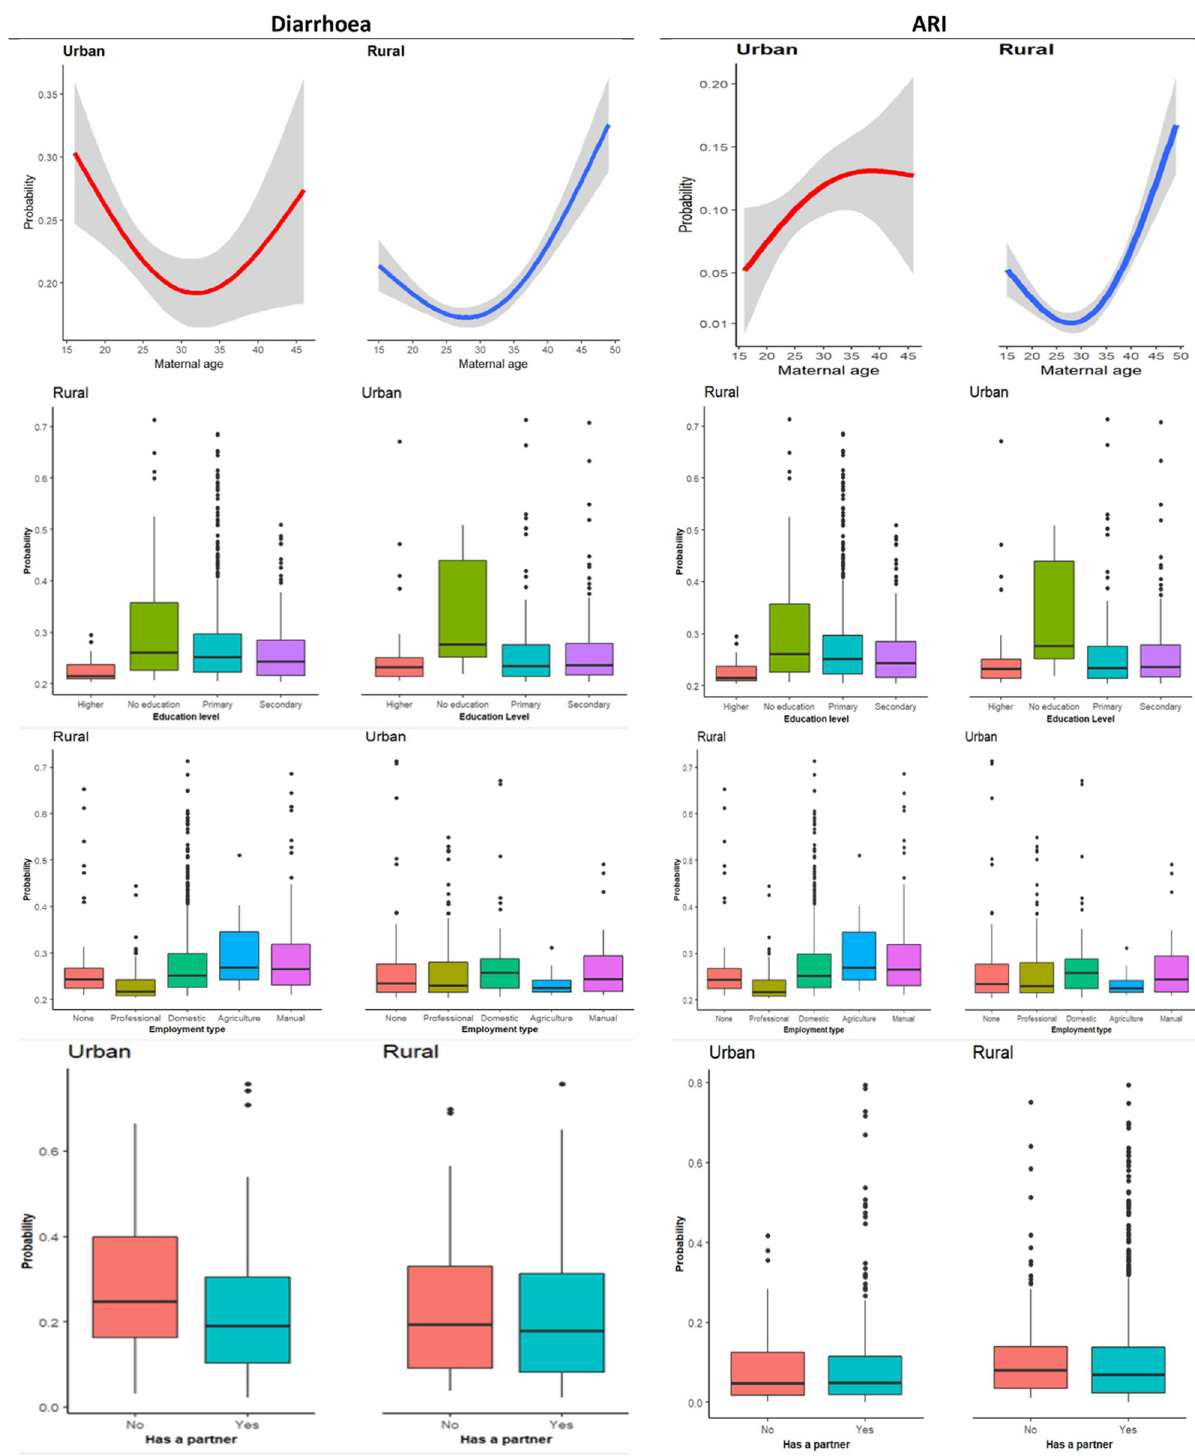
Fig 5. Association between maternal characteristics and child morbidities.